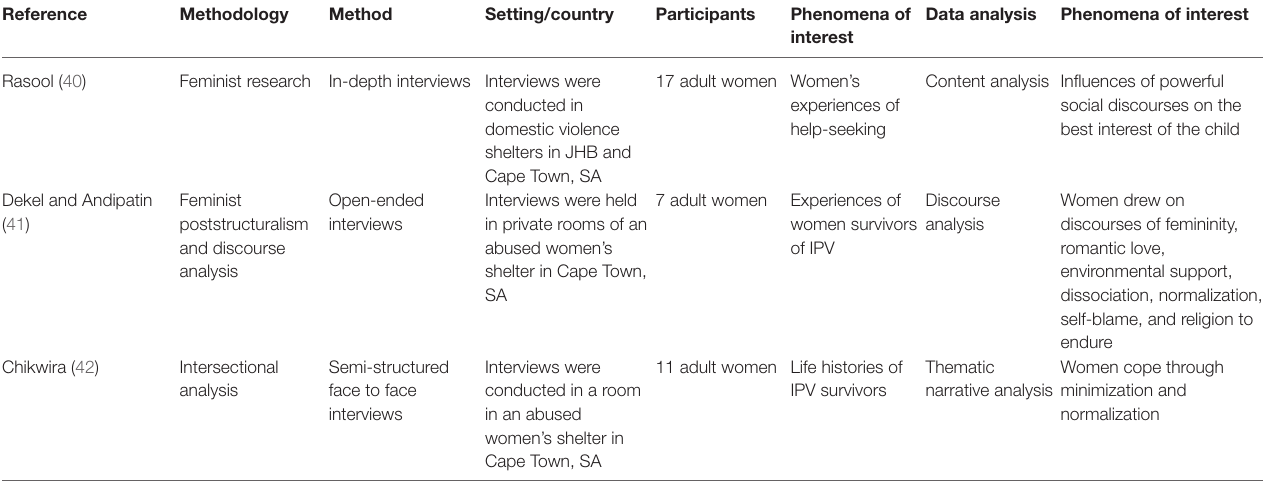
TABLE 3 | ConQual summary of findings. Synthesized